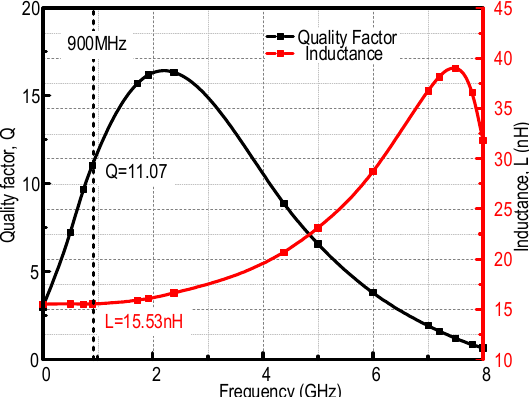
Figure 11. Quality factor and inductance of the matching inductor, L, over frequency.